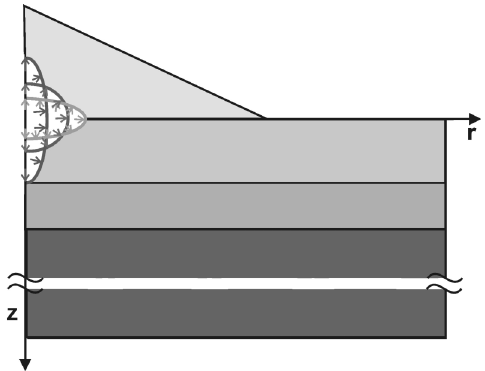
Fig. 9. Model geometry used to estimate the influence of topography and hetereogeneities on surface defor- mation and gravity field for the three geometry sources: HPS, VPS and SP. The arrows represent force line dis- tributions acting on the source surface. The features in the picture are not in